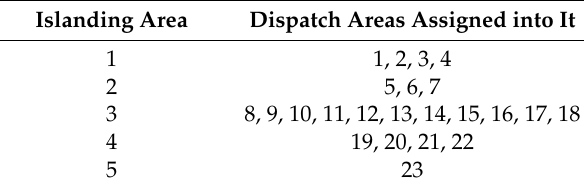
Figure 11. Controlled islanding areas of the test system. Table 1. Controlled islanding